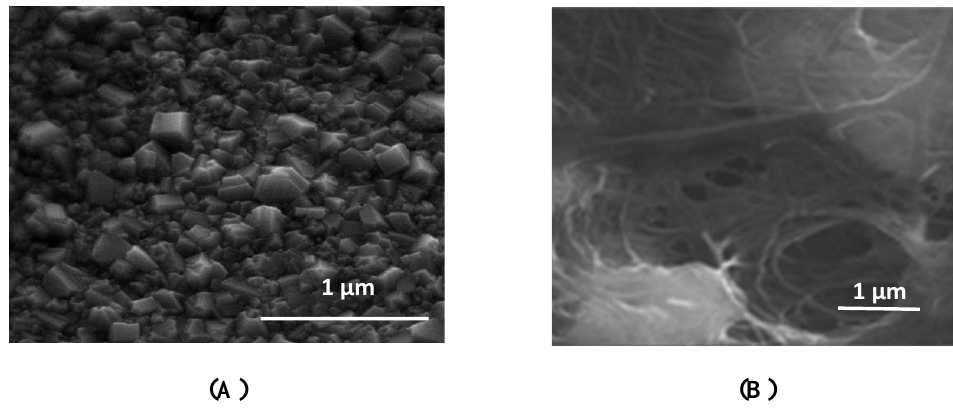
Figure 5. ( A ) SEM image of bare BDD; ( B ) SEM image of BDD/SD/SWCNTs/HRP.